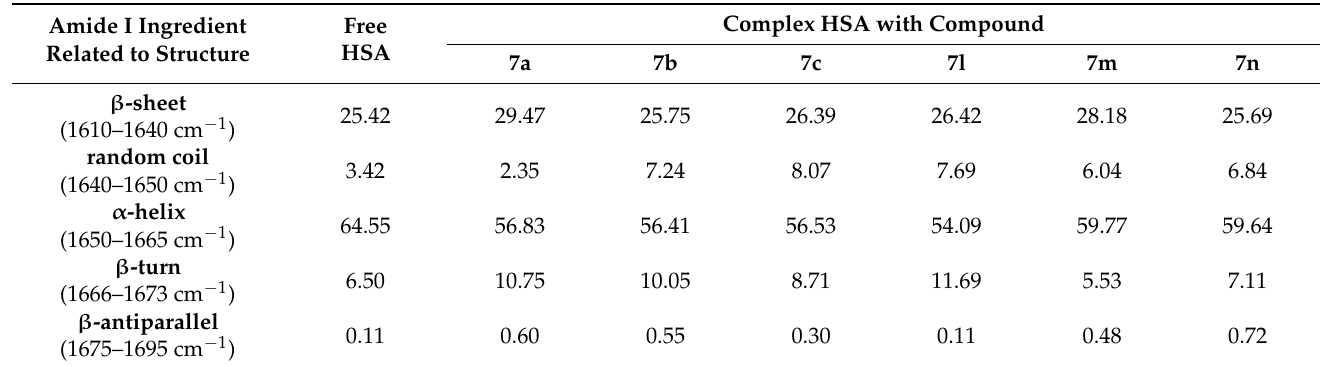
Table 13. Percentage of the secondary structure of free human serum albumin (HSA) and complexes with studied compounds.